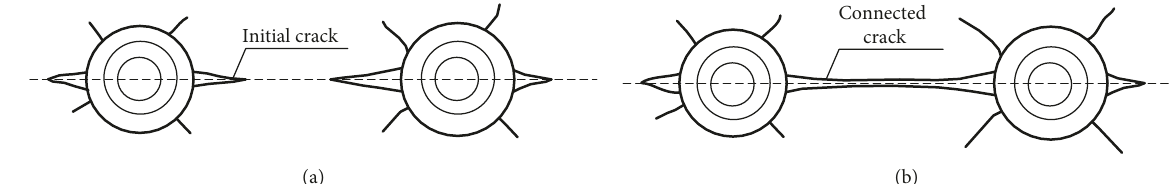
Figure 2: Formation of a presplit face.